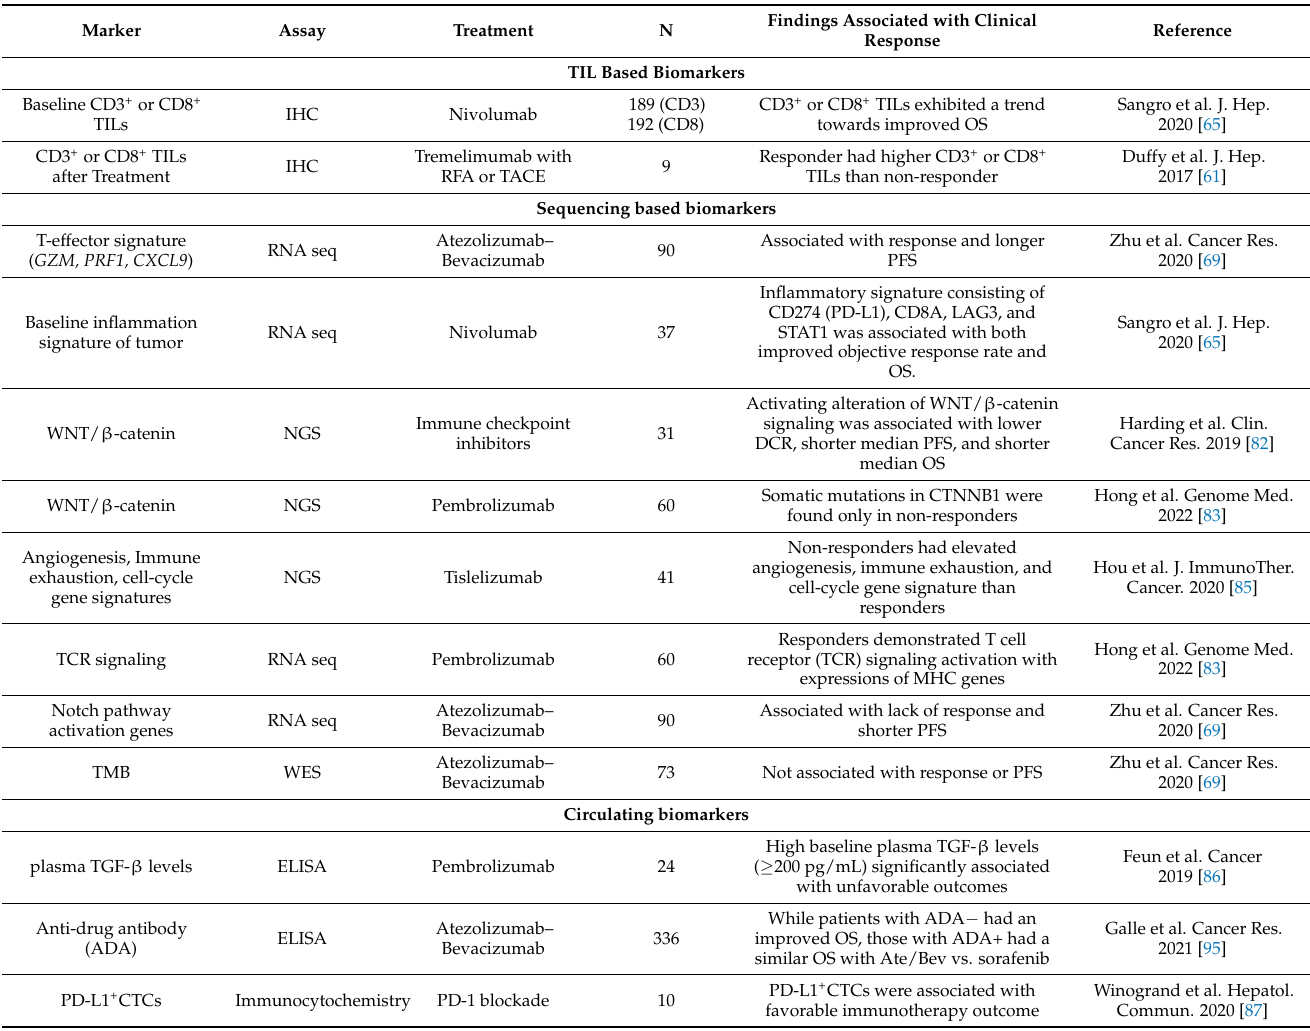
Table 2. Translational